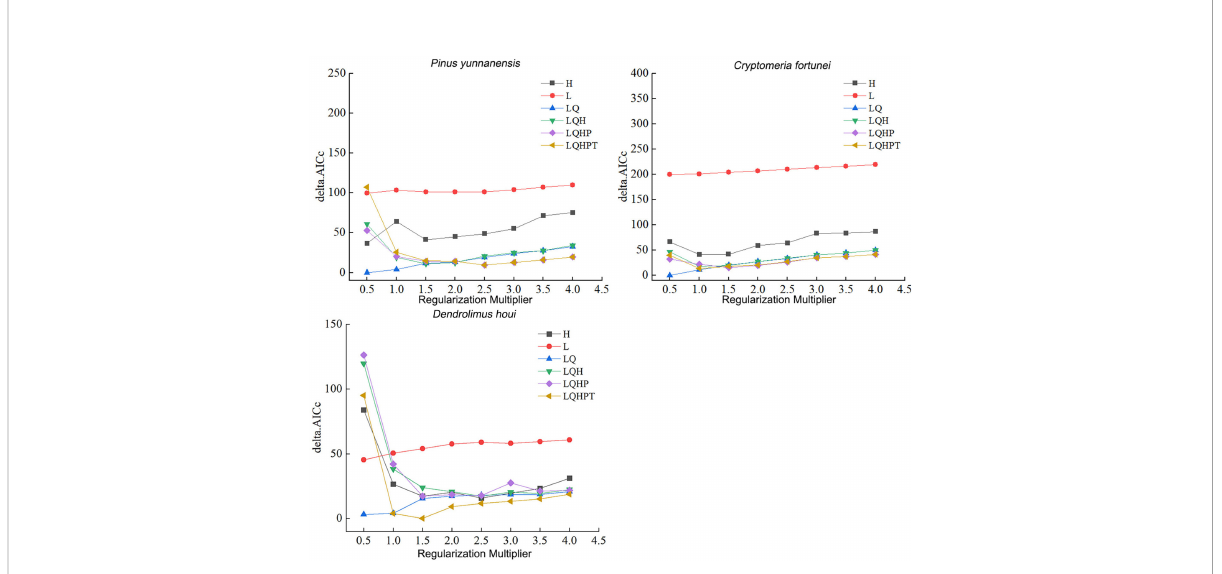
FIGURE 2 Delta AICc for P. yunnanensis , C. fortunei , and D. houi from models under different parameter